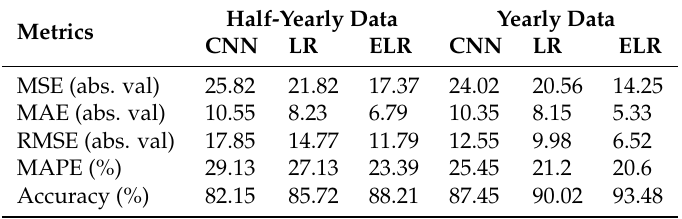
Table 15. Load performance metrics comparison for one month using the UMass Electric